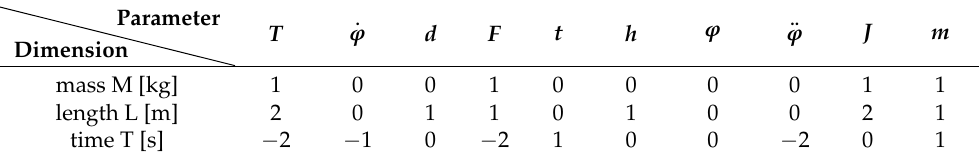
Table 1. Result of the dimensional analysis. The parameters T , quantities of the system, since they represent the difference of the scaled and unscaled system and the physical quantities in the virtual coupling.